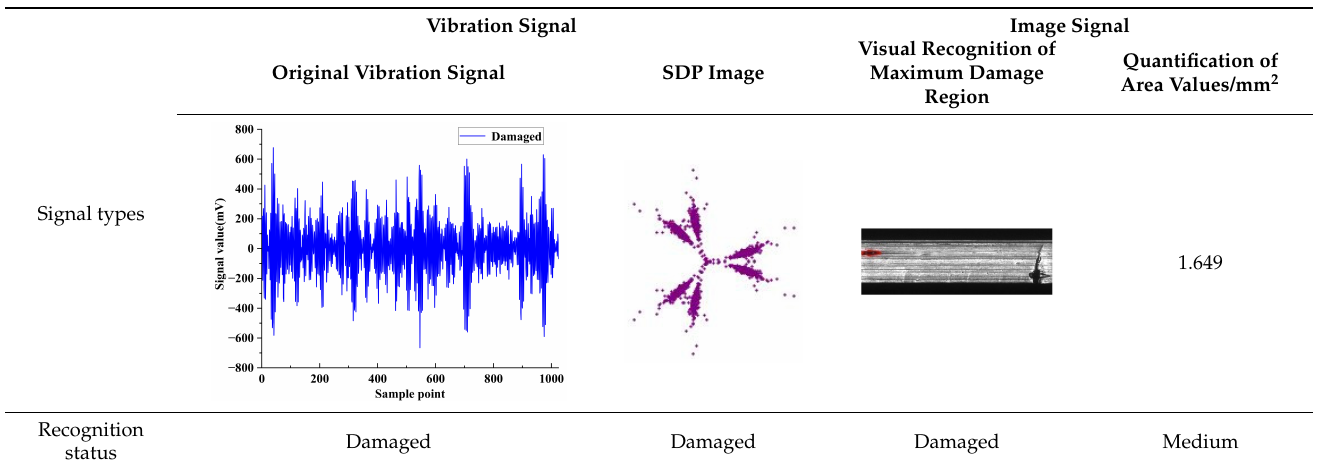
Table 11. Contact fatigue damage of a specimen and the recognition